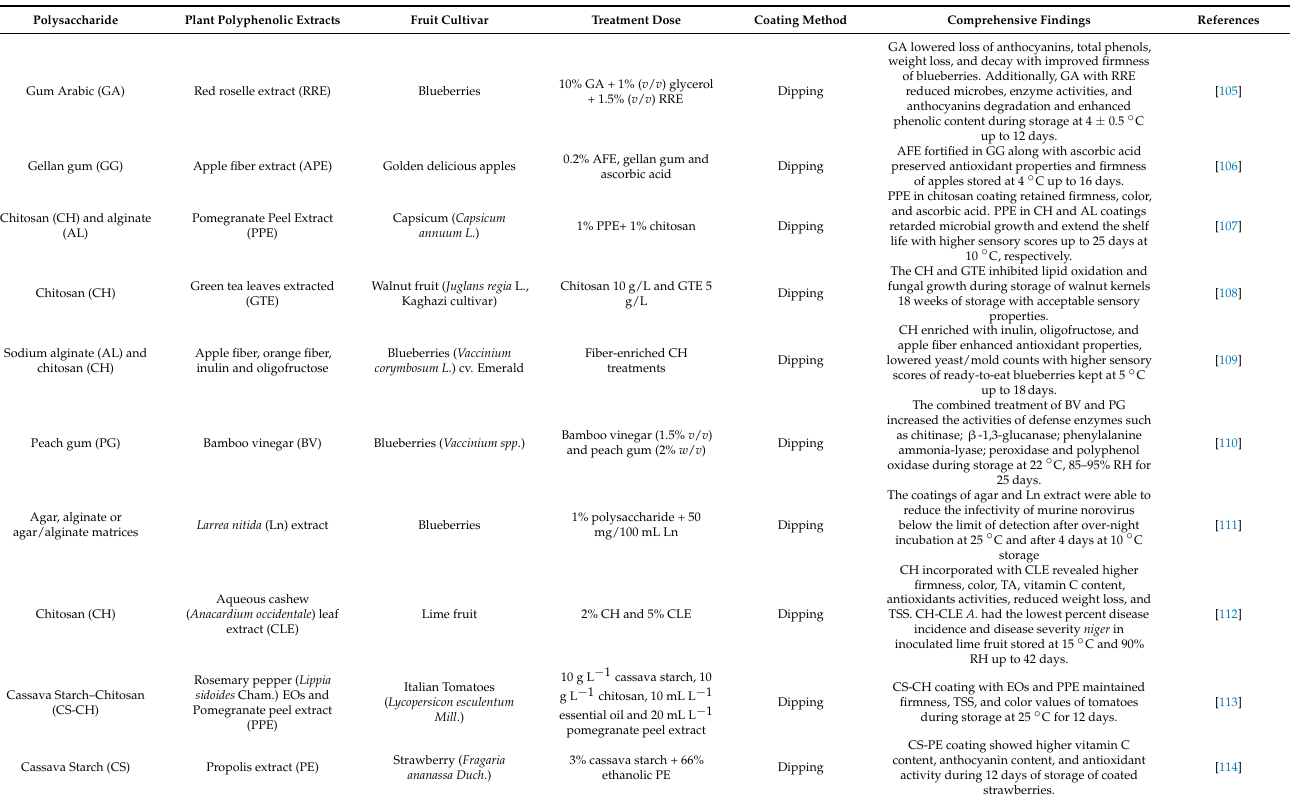
Table 3. Polysaccharides combined with plant polyphenolic extracts for the quality preservation of fresh fruits during postharvest storage.